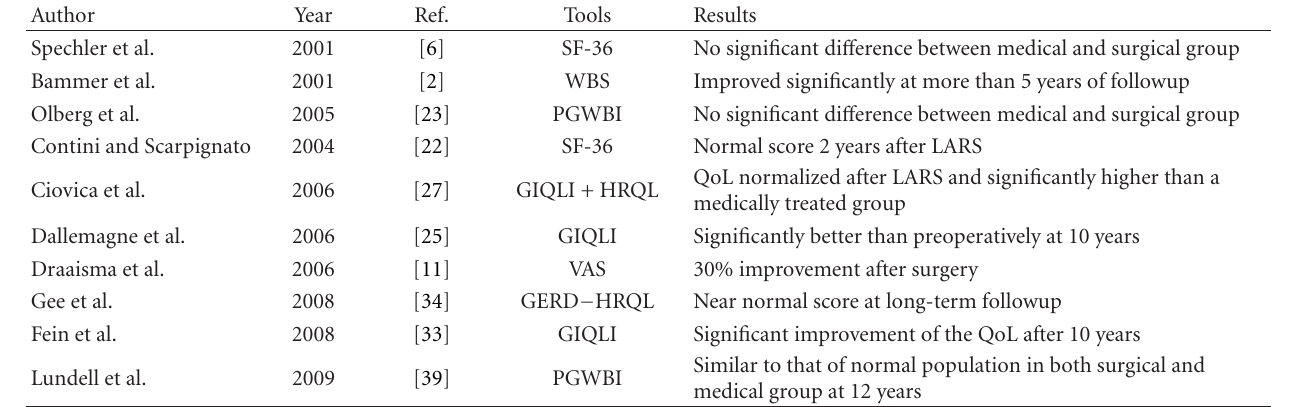
Table 2: HRQoL Assessment with di ff erent questionnaires and their